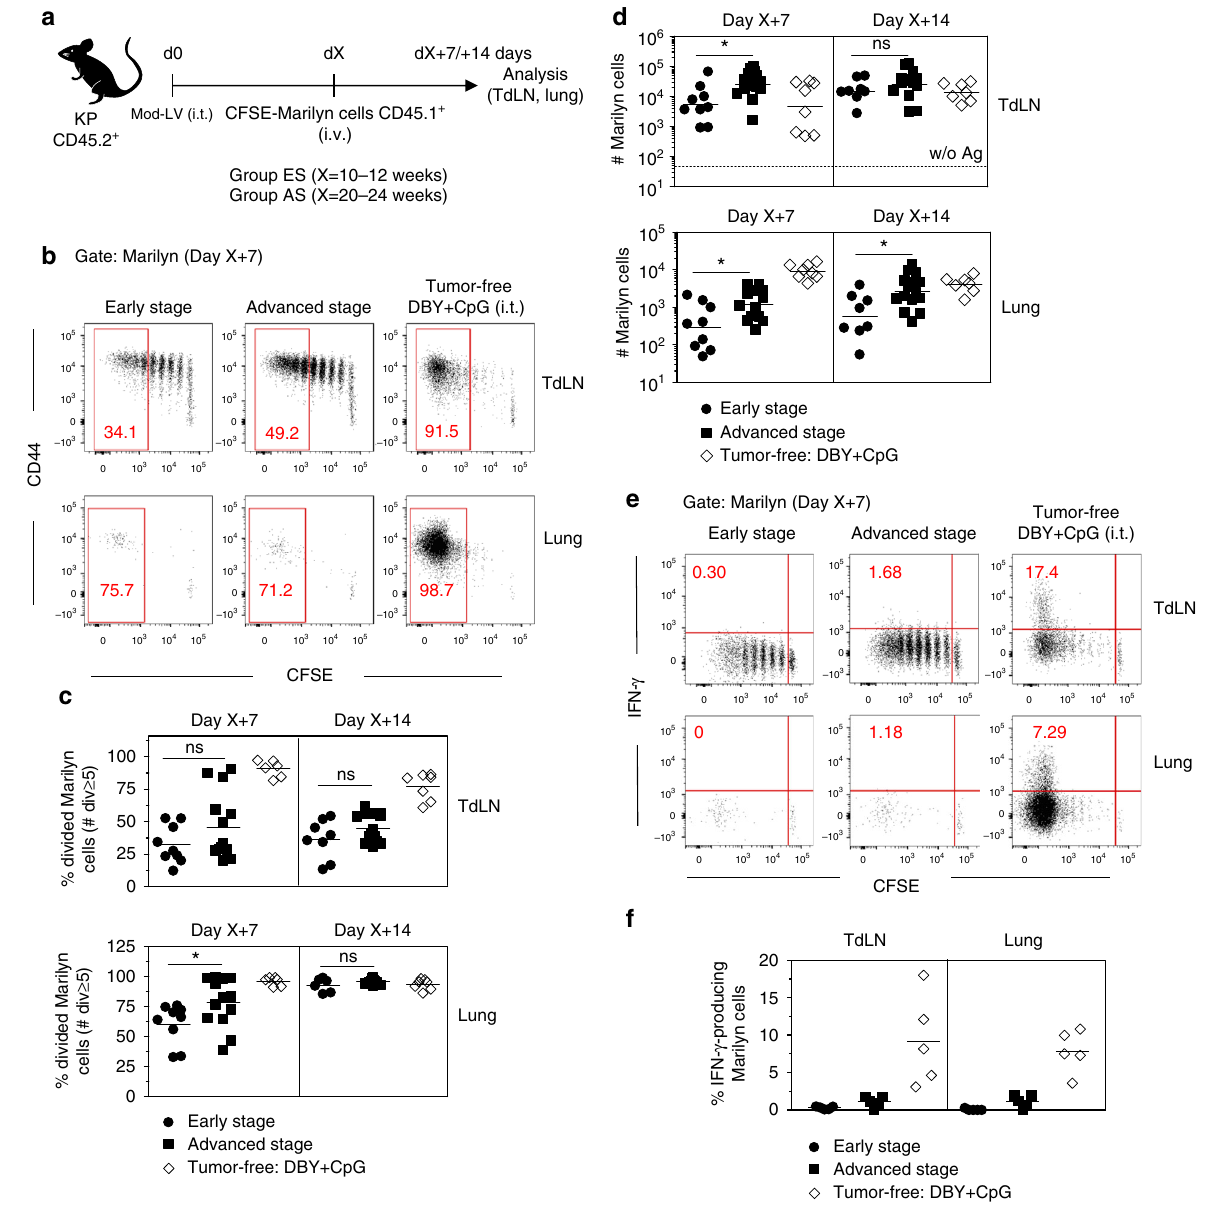
Fig. 1 Priming of tumor Ag-speci fi c naive CD4 + T cells is not suf fi cient for full activation and migration to tumor site. a CFSE-labeled naive Marilyn cells were transferred into mice bearing ES or AS tumors. Their activation and proliferation were assessed 7 and 14 days after transfer in the TdLN and in the lung. b , c Pattern of proliferation and quanti fi cation (frequency of ≥ 5 divisions). Red gates indicate ≥ 5 cell divisions. Tumor-free B6 mice receiving 200 ng of DBY + CpG i.t. were used as controls. d Number of recovered Marilyn cells. Dashed line: basal number in the absence of Ag. Pooled data from three independent experiments. ns: non-signi fi cant, * p <0.05 Mann – Whitney U test. e Example of IFN- γ -producing Marilyn cell staining according to cell division after ex-vivo restimulation with PMA/Ionomycin for 4 h. f Quanti fi cation (frequency). One representative experiment out of three is